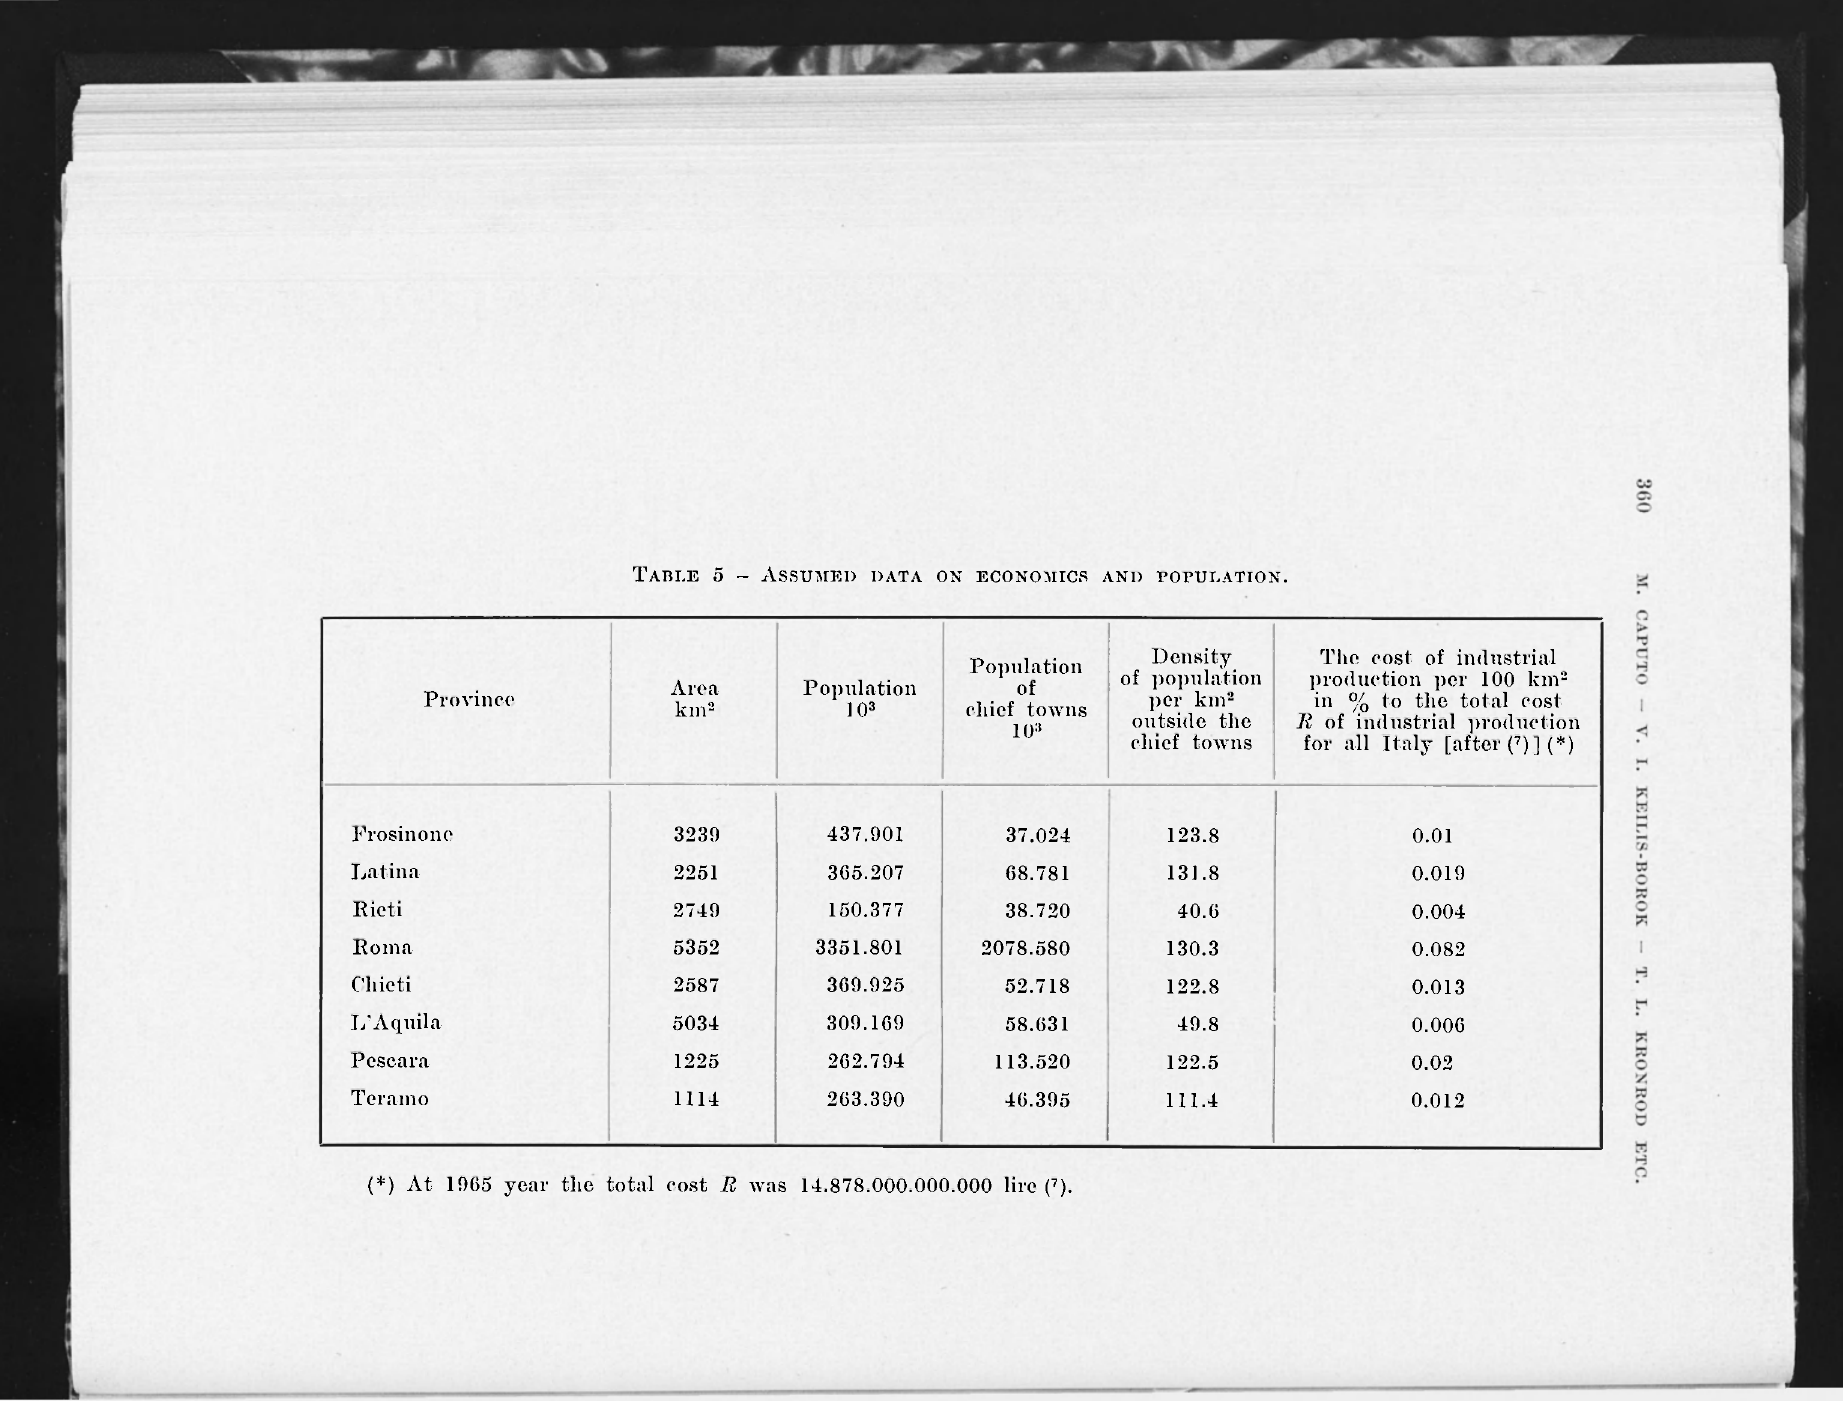
TABLE 5 - ASSUMED DATA ON ECONOMICS AND